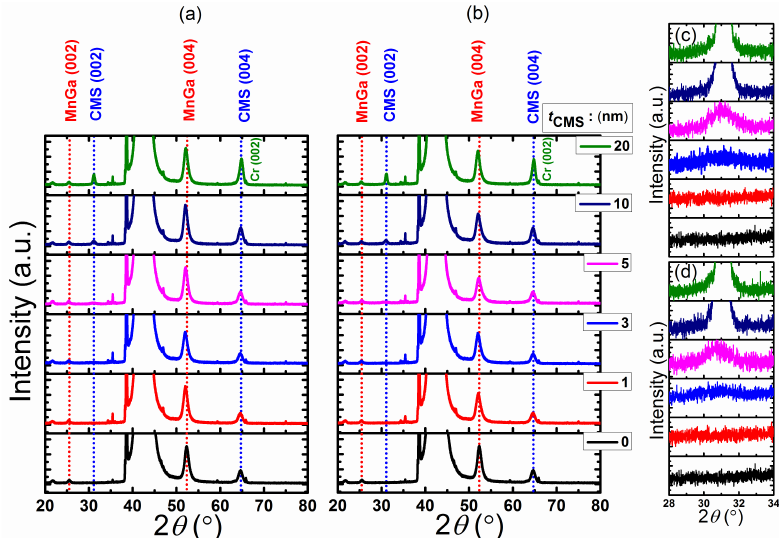
MnSi (CMS) (0–20 nm)/MnGa (30 nm) 2